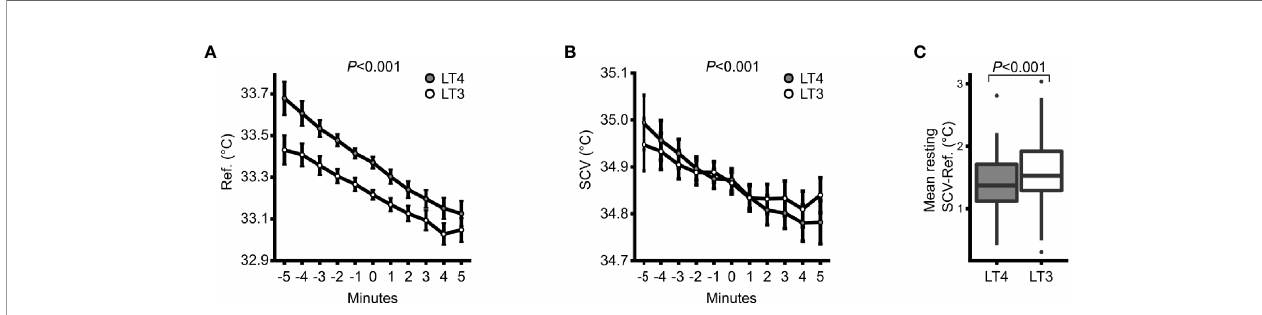
FIGURE 4 | Infrared thermography. (A) Response in sternal reference region temperature to cold stimuli on LT4 (grey) and LT3 (white) treatment. Minutes -5 to 0 depicts the response to room air and minutes 0 to 5 the response to hand immersion of both hands into cold water. (B) Same as for (A) , but for supraclavicular (SCV) temperature. Data are means ± 95% con fi dence intervals. (C) A box & whiskers plot for resting SCV temperature minus sternal reference temperature within each of the two treatment periods.